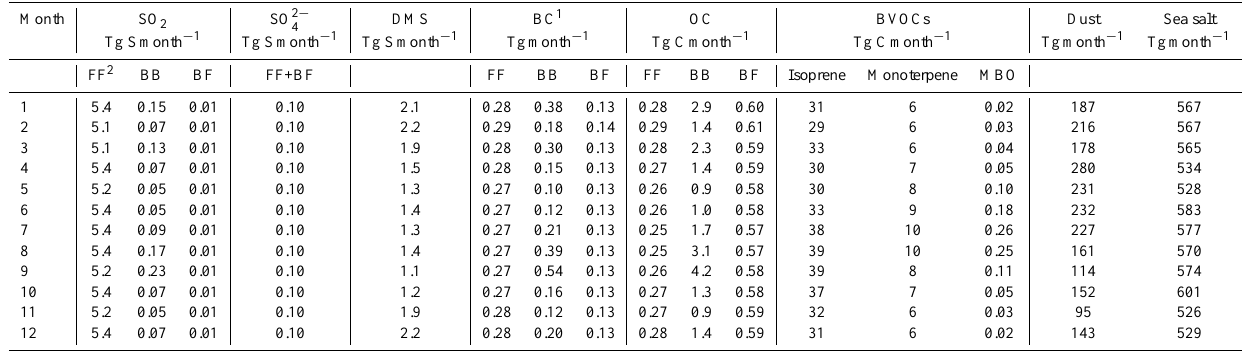
Table 2. Global monthly emissions of aerosols and gaseous precursors from GEOS-Chem simulation of 2008. Month SO 2 SO 2 − 4 DMS